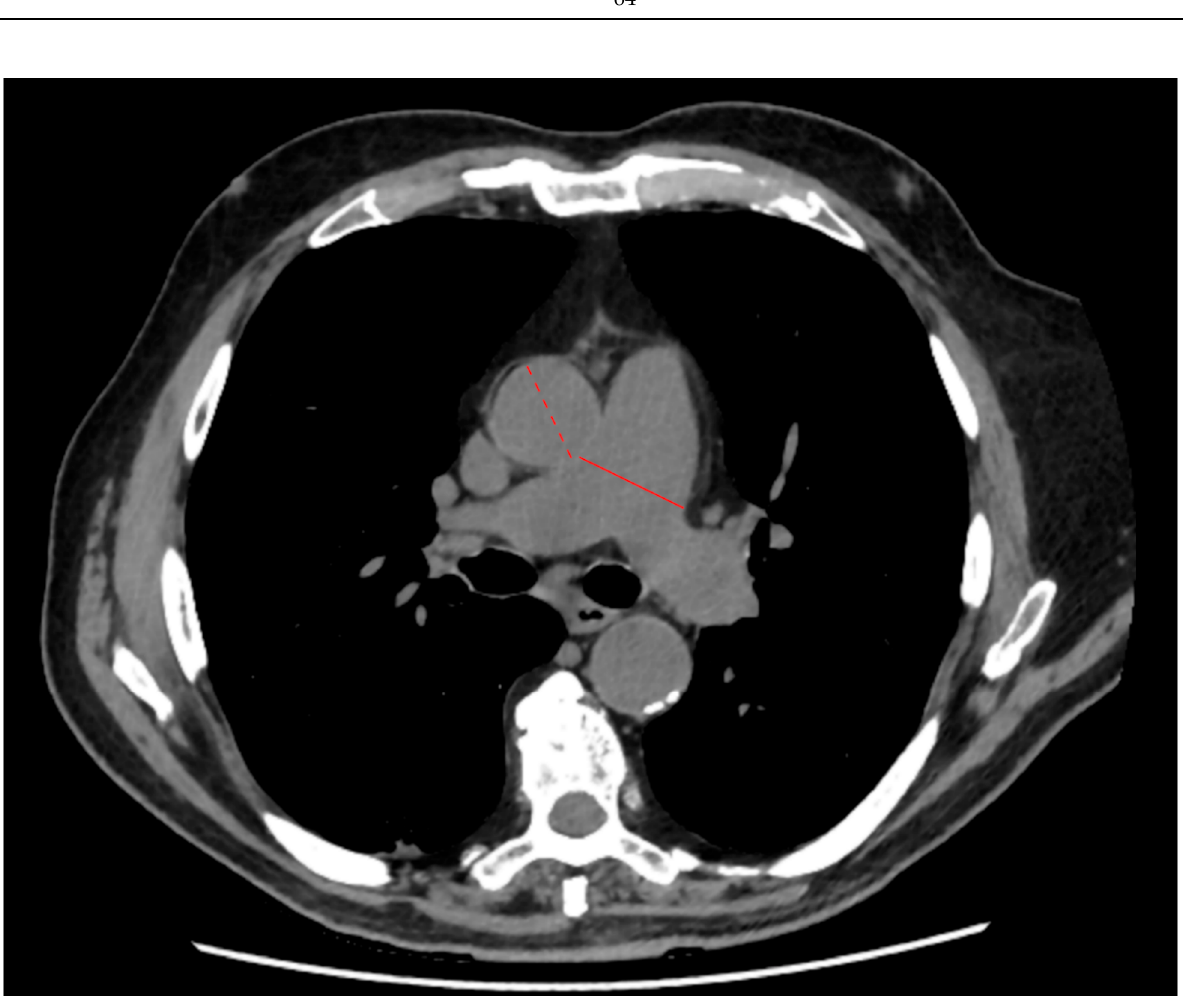
Figure 1. Example of axial slice selected at the level of pulmonary arterial main trunk bifurcation. The solid and dashed lines identify the maximum diameters of the pulmonary artery and ascending aorta, respectively.